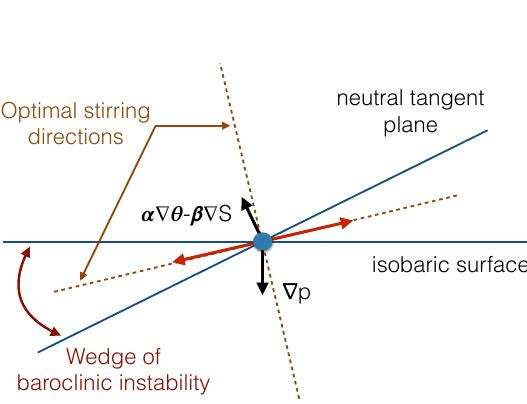
Figure B1. Schematics illustrating the key directions controlling the energy cost of adiabatic stirring. The red arrows define the optimal direction for stirring and is located in the so-called wedge of baroclinic instability whose origin can be traced back to [31]. The neutral direction associated with zero energy cost is indicated by the big blue dot and is perpendicular to the